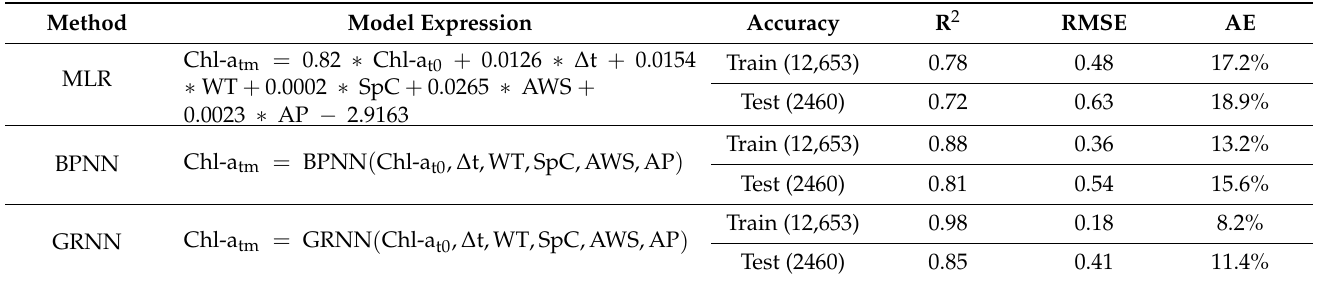
Table 3. Accuracy evaluation of multi-parameters forecasting models for all-valid Chl-a. Method Model